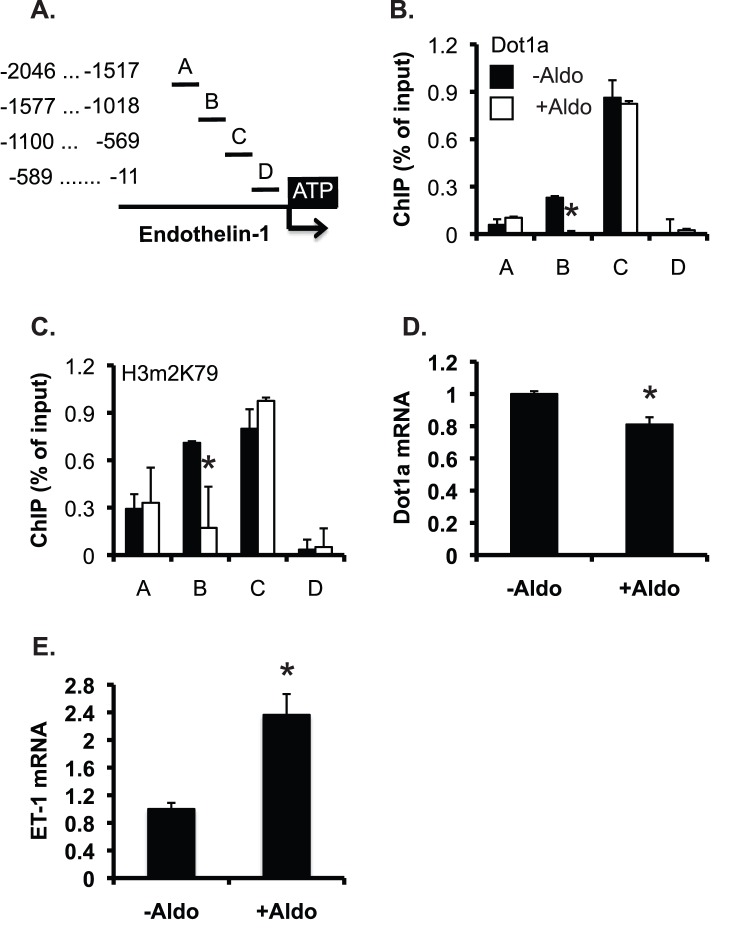
Aldosterone reduces binding of Dot1a and H3 K79 methylation at the Edn-1 5′ regulatory region and upregulates ET-1 mRNA expression in IMCD3 cells.(A) Diagram of the 5′ regulatory region of Edn-1. (B–C) Chromatin immunoprecipitation showing Dot1a and H3m2K79 binding in the 5′ regulatory region of Edn-1. Chromatin from IMCD3 cells treated with ethanol as vehicle control (-Aldo) or 1 µM aldosterone (+Aldo) for 24 h was immunoprecipitated by the rabbit antibodies specific for Dot1a (B) and H3m2K79 (C), followed by real-time qPCR with primers amplifying subregions A-D shown in A. Relative ChIP efficiency was defined as the immunoprecipitated amount of materials present as compared to that of the initial input sample. *: P<0.05 vs. –Aldo within the same subregion. (D–E) IMCD3 cells were treated as in B–C and analyzed by real-time RT-qPCR for mRNA expression of Dot1a (D) and ET-1 (E). n = 2. *: P<0.05 vs. –Aldo.